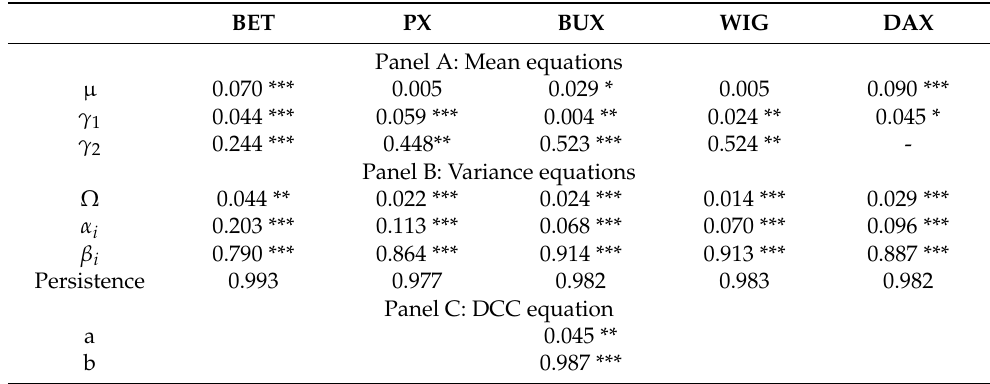
Table 3. Estimation results from the DCC-GARCH models (CEEC-Germany). BET PX BUX WIG DAX Panel A: Mean